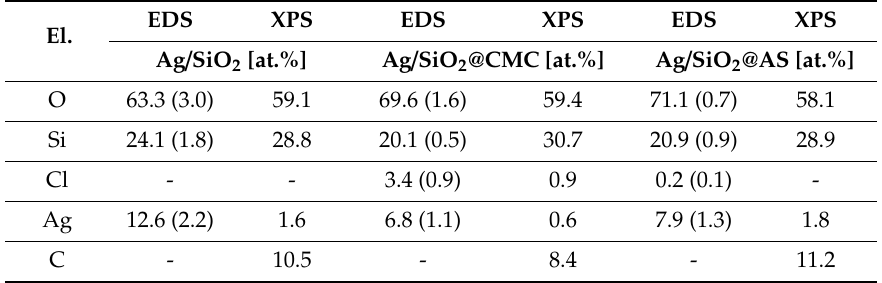
Figure 7. The XPS spectrum of the Cl 2p core level with the result of the fitting for Ag / SiO 2 @CMC. Table 4. The average atomic element concentration for the initial and modified silver-silica nanocomposites was estimated for the bulk (SEM-EDS) and surface (XPS). The data in the parentheses refer to the standard deviation data that was obtained based on the measurements of five di ff erent points. El.